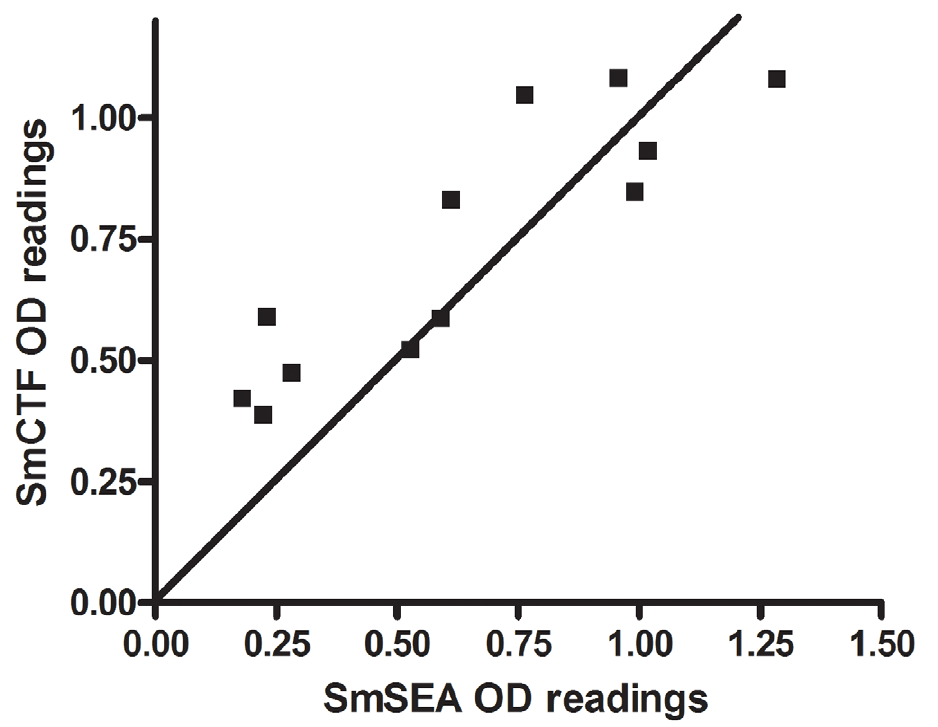
Figure 6. LSTM: correlation between S.mansoni cercarial transformation fluid (SmCTF) and soluble egg antigen (SmSEA) in ELISA. Results for sera from patients infected with S. mansoni